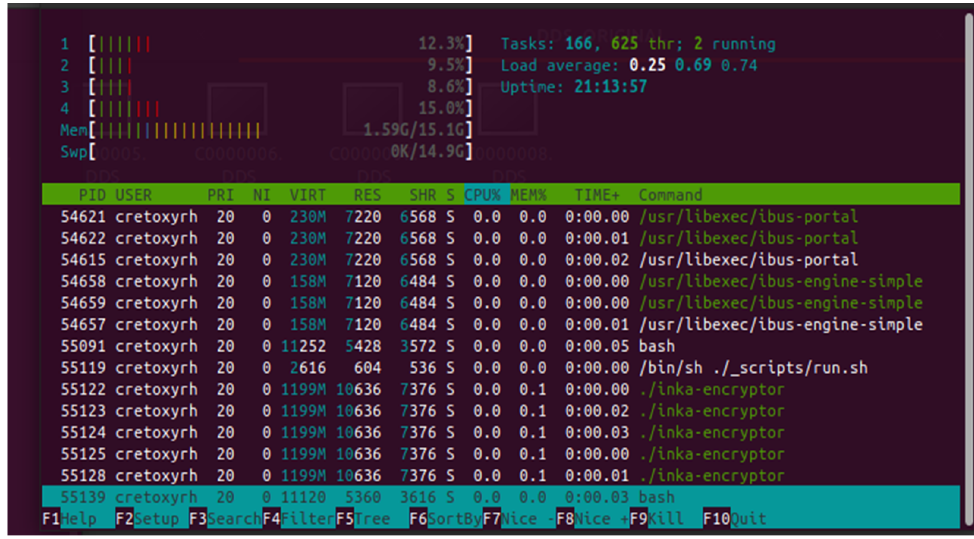
Figure 9. Computing performance.